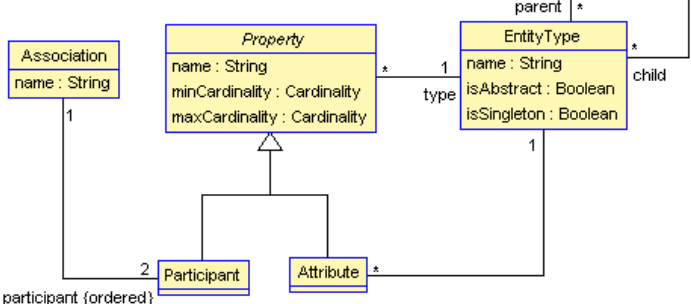
Figure 1. The metamodel of the schemas considered in this